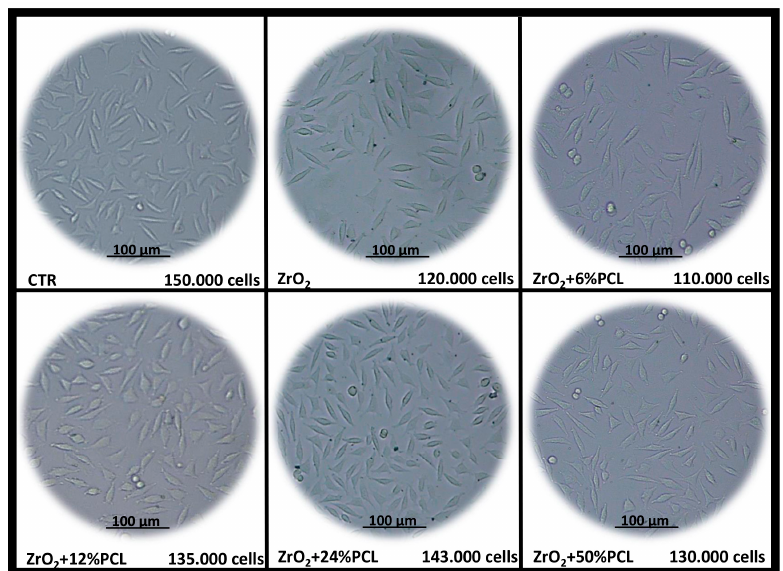
Figure 1. Typical phase-contrast images of NIH 3T3 cells treated with and without PCL-free ZrO 2 material and poly(e-caprolactone) (PCL)/ZrO 2 hybrids with different percentages of PCL (6 wt %, 12 wt %, 24 wt %, 50 wt %) for 48 h.